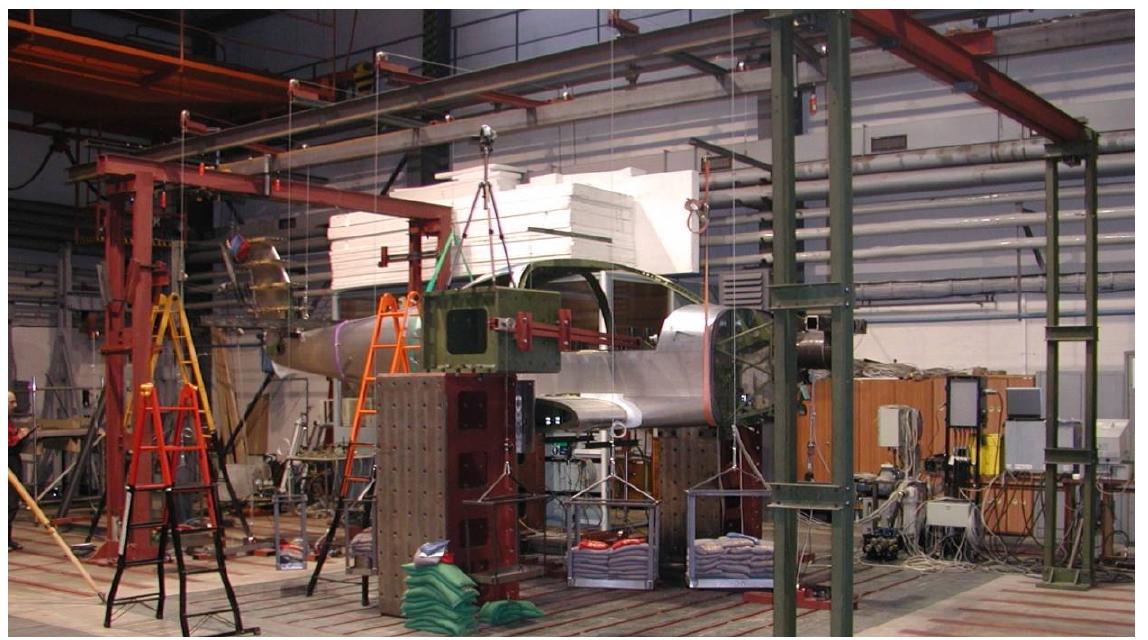
Fig 3. Realization of the test – case manoeuvre of vertical surfaces